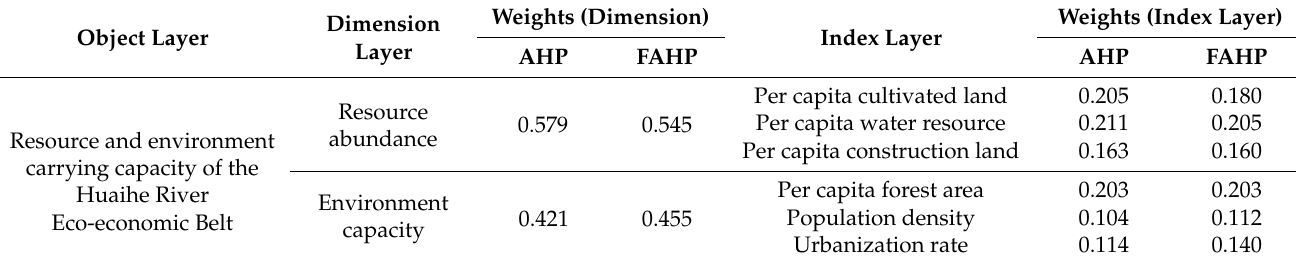
Table 4. Weights of various evaluation indexes of resource and environment carrying capacity.